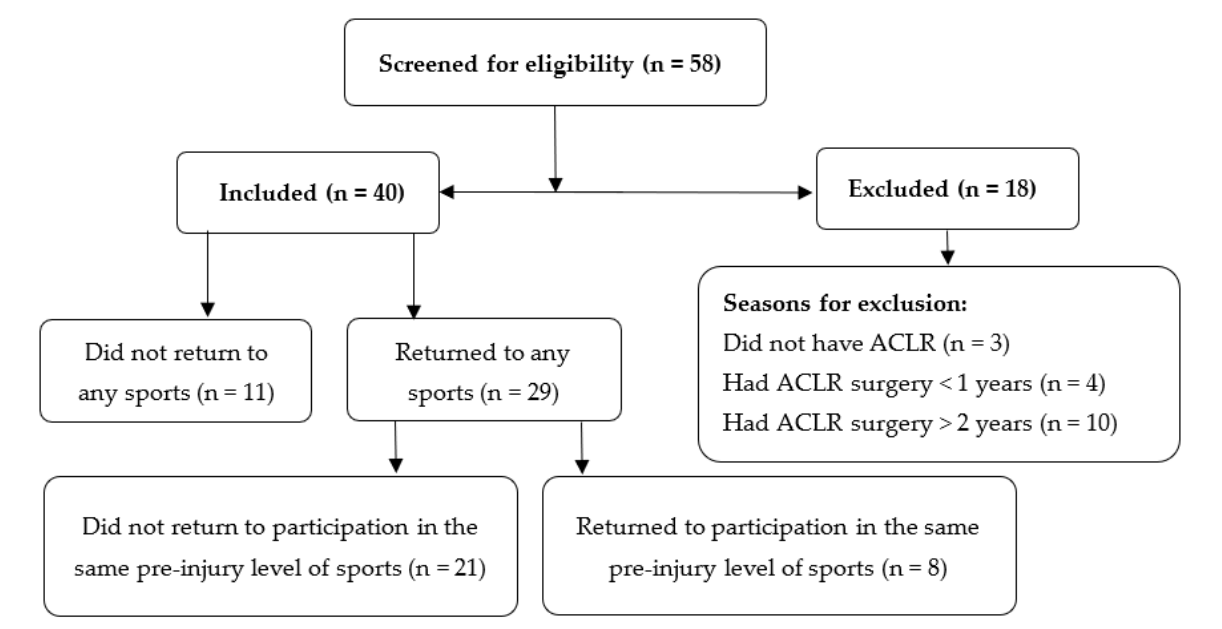
Figure 1. Flow diagram for athletes’ participation in this study.